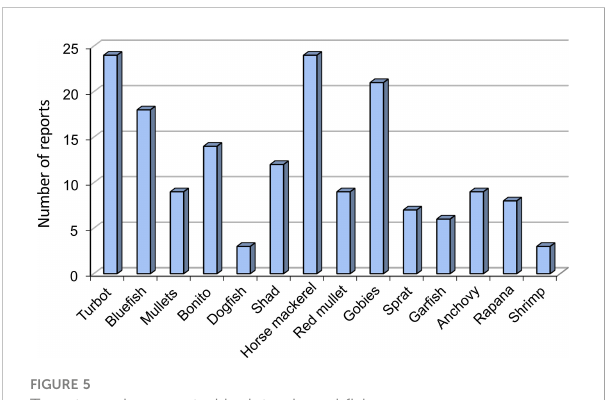
FIGURE 5 Target species reported by interviewed fi